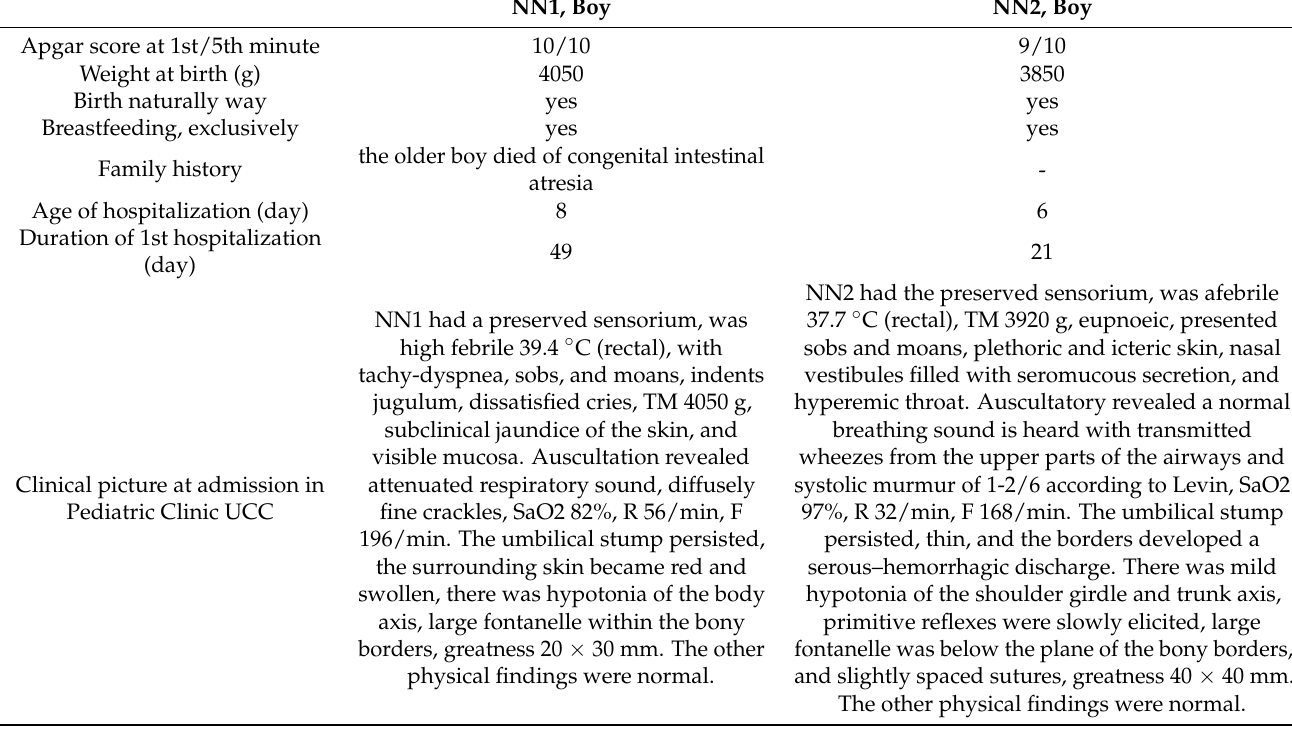
in Table 1. The results of hematological, biochemical, immunological, and microbiological analyses of both newborns are shown in Table 2. Although both newborns were infected with the same strain L. pneumophila (serogroup 2-15), consumption coagulopathy followed by severe clinical picture developed in NN1. Biomarkers of infection (C-reactive protein (CRP), procalcitonin (PCT), and interleukin 6 (IL 6)) were significantly elevated in NN1 as opposed to NN2 (Table 2). For NN1, ultrasound findings of femoral and iliac blood vessels, brain ultrasound, then lung radiography and chest scanner are shown in Figures 1–3, while for NN2, lung radiography is shown in Figure 4. Serological tests of tracheal aspirate and urine confirmed the diagnosis of LD for both newborns (Table 2). NN1 was treated with macrolide from day 6 of the disease (azithromycin, then erythromycin) and ciprofloxacin (quinolone) from day 10 of the disease, while NN2 was treated with macrolide from day 3 of the disease (azithromycin, then erythromycin) and ciprofloxacin from day 11 of the disease. Table 1. Relevant clinical features of neonates at admission. NN1, Boy NN2, Boy 9/10